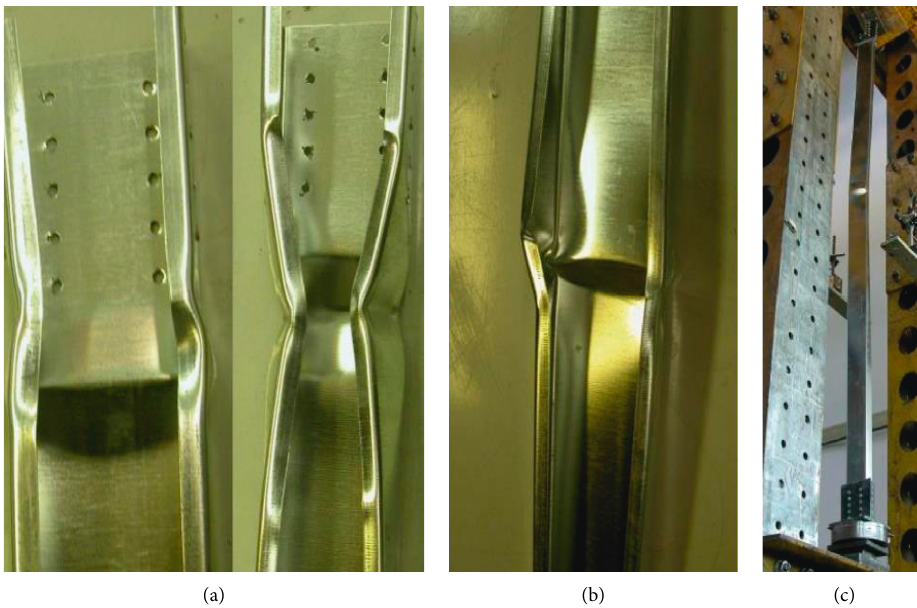
Figure 3: Failure modes of: (a) 300mm, (b) 600mm, and (c) 2,000 mm columns [1].